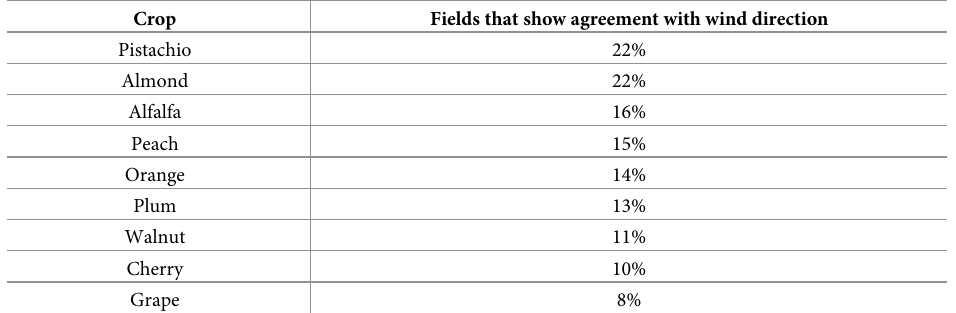
Table 3. The most prevalent crops in the study area and their proportion of fields that agreed with wind direction ( < 30˚ difference). Crop Fields that show agreement with wind